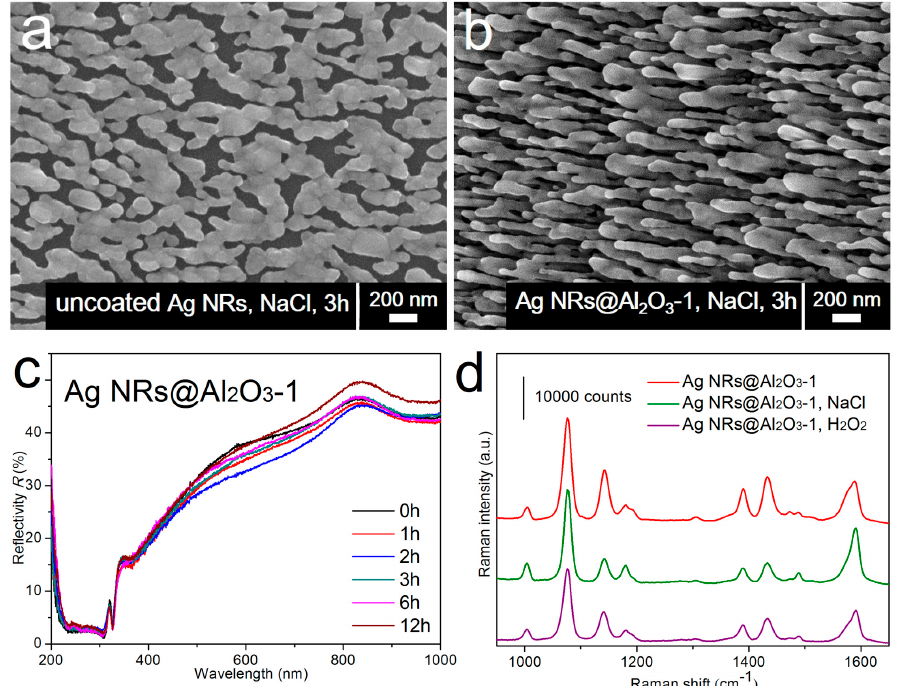
Figure 5. SEM images of ( a ) pristine AgNRs and ( b ) the AgNRs substrate coated with 1-cycle Al 2 O 3 after being merged in a 30 mM NaCl solution for 3 h; ( c ) reflectance spectra variations of the AgNRs substrate coated with 1-cycle Al 2 O 3 within a 12 h NaCl erosion time; ( d ) SERS performance of AgNRs coated with 1-cycle Al 2 O 3 before/after NaCl (30 mM, 3 h) and H 2 O 2 (2.2%, 0.5 h) immersion, using 1 × 10 − 6 M 4-aminothiophenol (4-ATP) as probing molecules (Reprinted with permission from